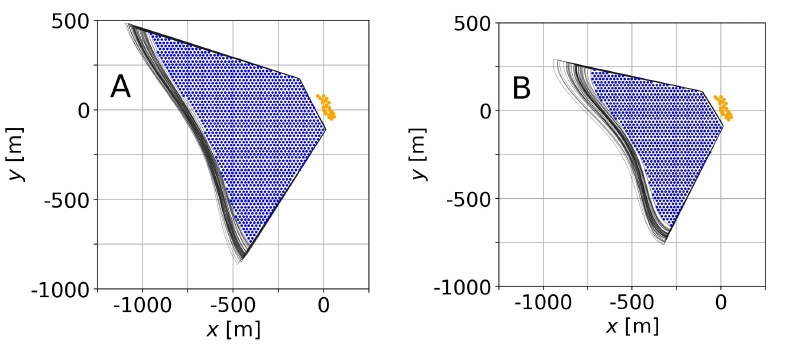
Figure 6. xy domain for videos 1 ( A ) and 2 ( B ) as the intersection of all the projections of the pixel domain into the horizontal plane z = z msl , mean sea level. Black lines are the boundaries for different video frames, blue dots stand for the mesh within the intersection, and orange points are GCP